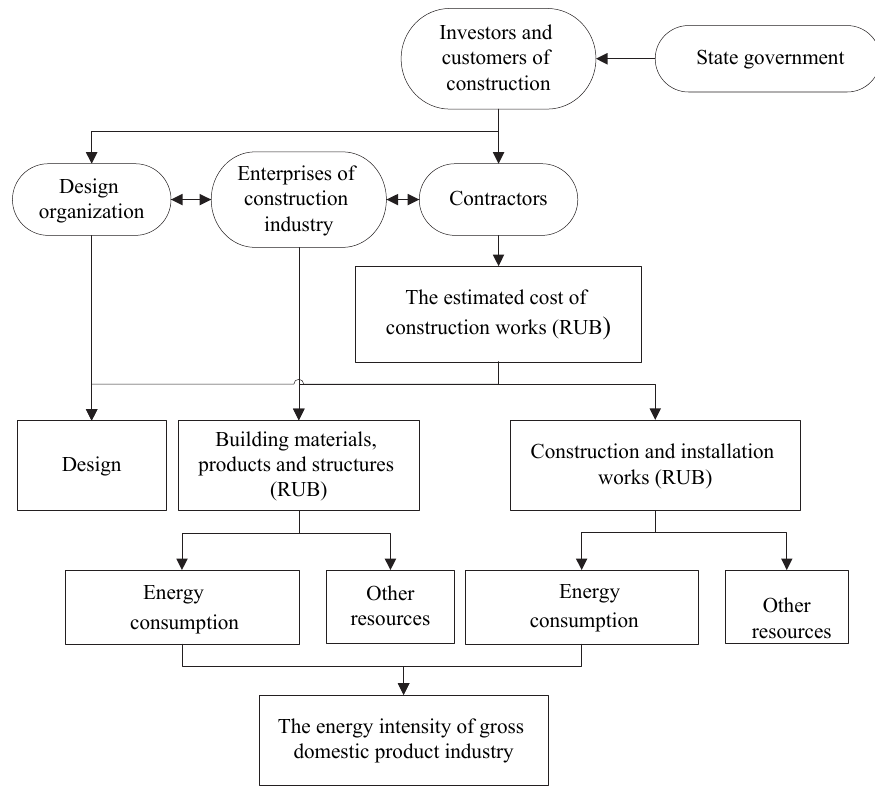
Fig. 1. The structure of products of the construction